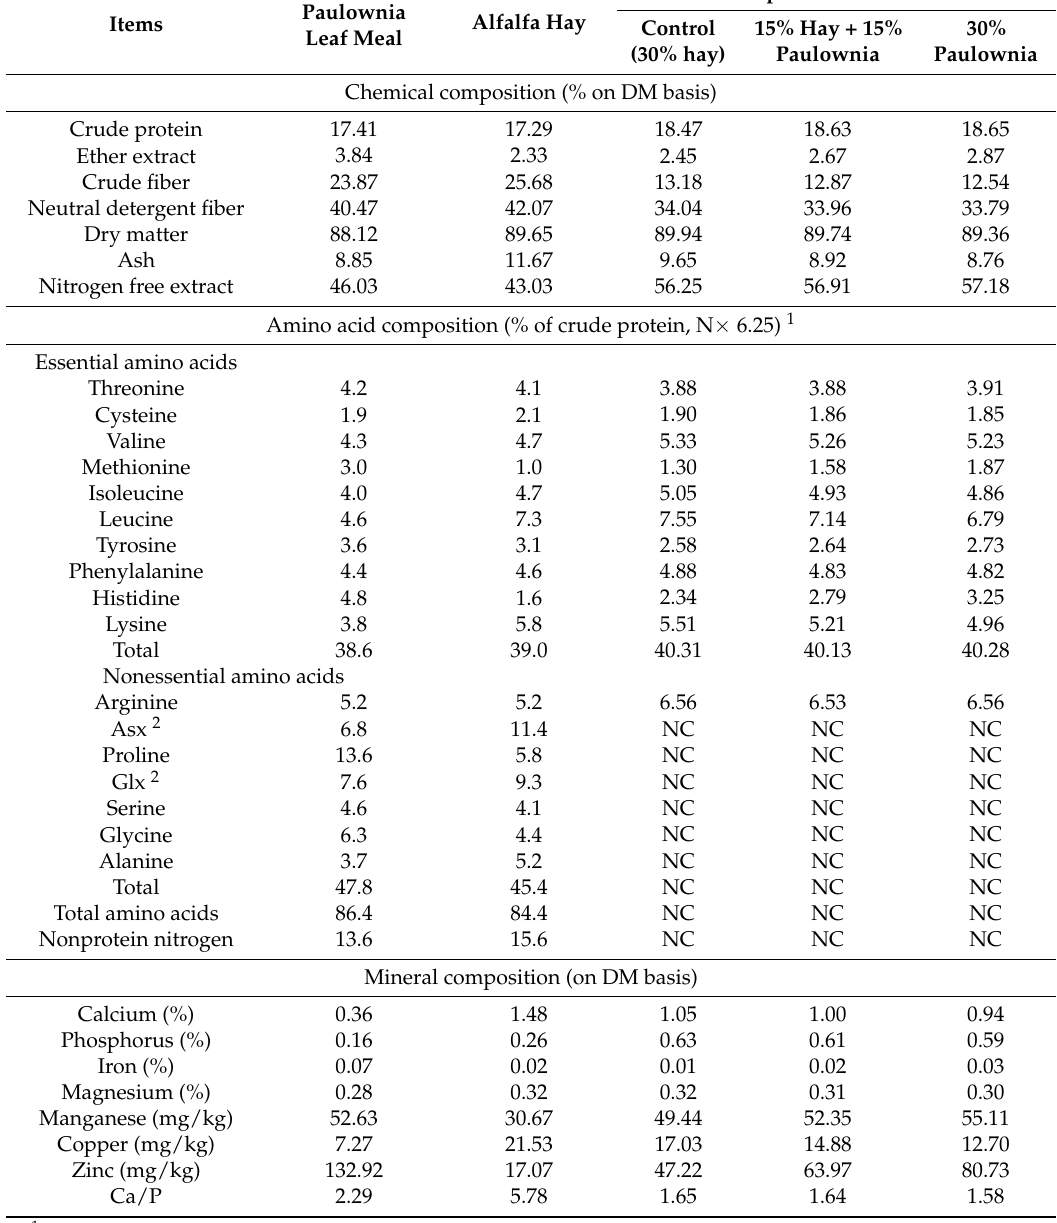
Table 2. Nutrient composition of paulownia leaf meal, alfalfa hay, and experimental diets.